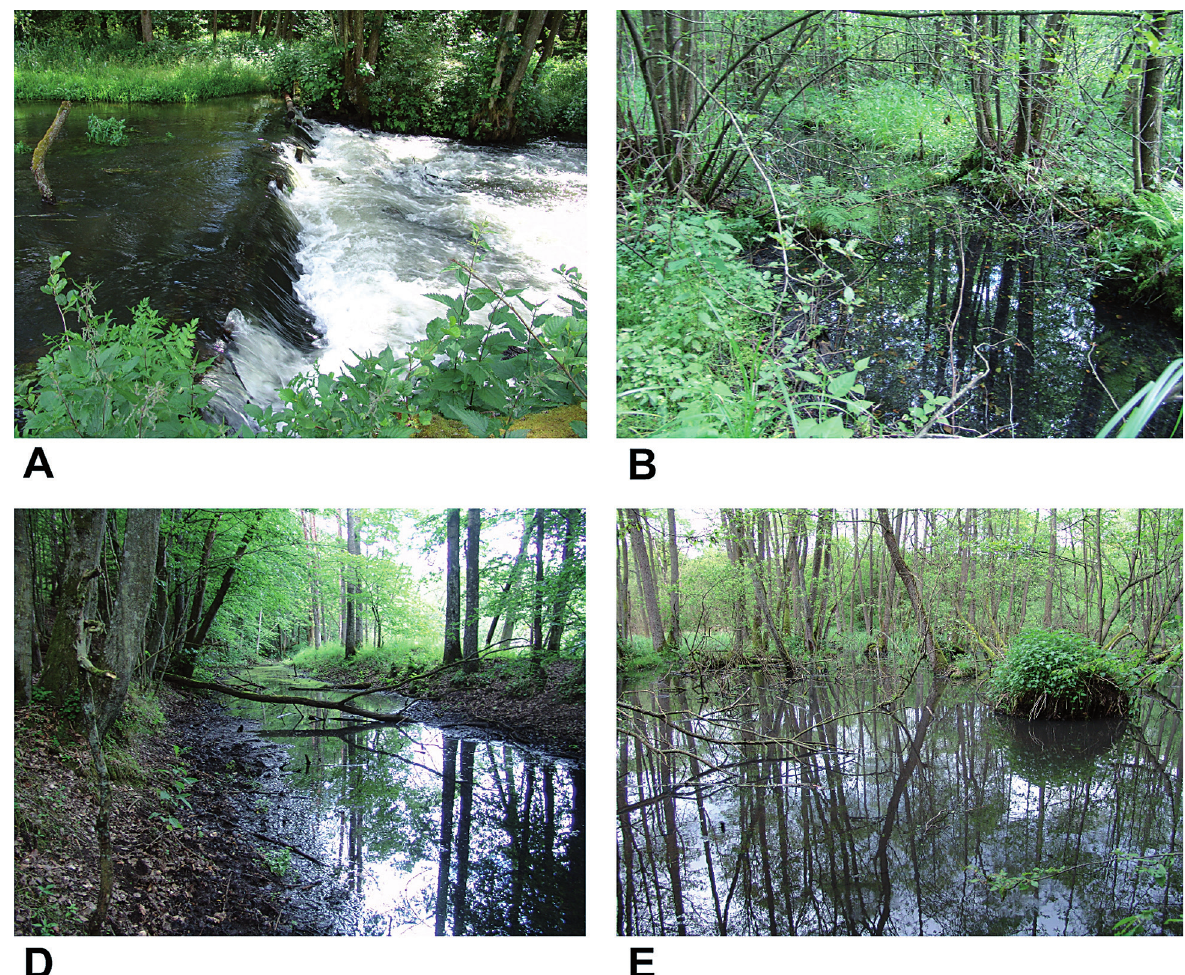
Fig. 2. Elements of the old irrigation systems in the Parsęta